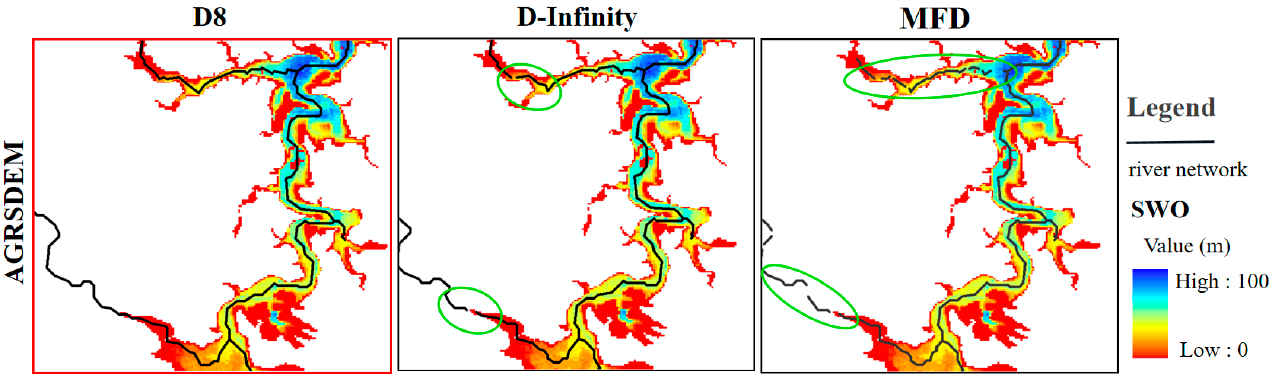
Figure 13. Comparison maps of different algorithms of Surface Stream Simulation (significant changes are marked in green).